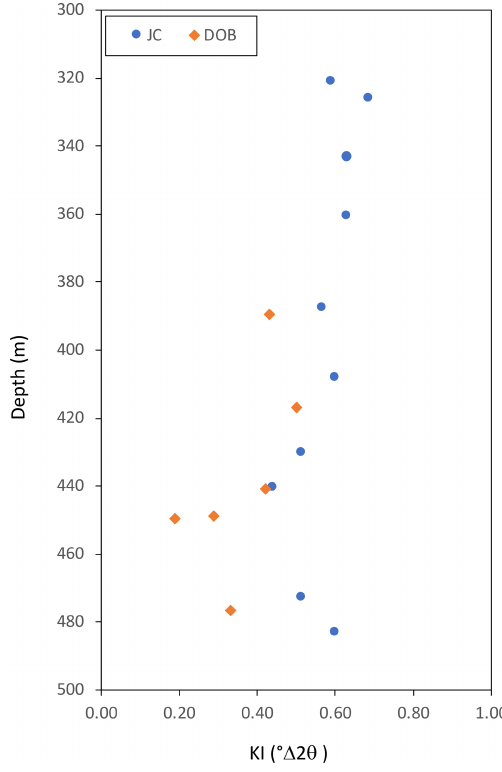
Figure 10. KI values versus present depth from boreholes Julia Creek 1 and Dobbyn